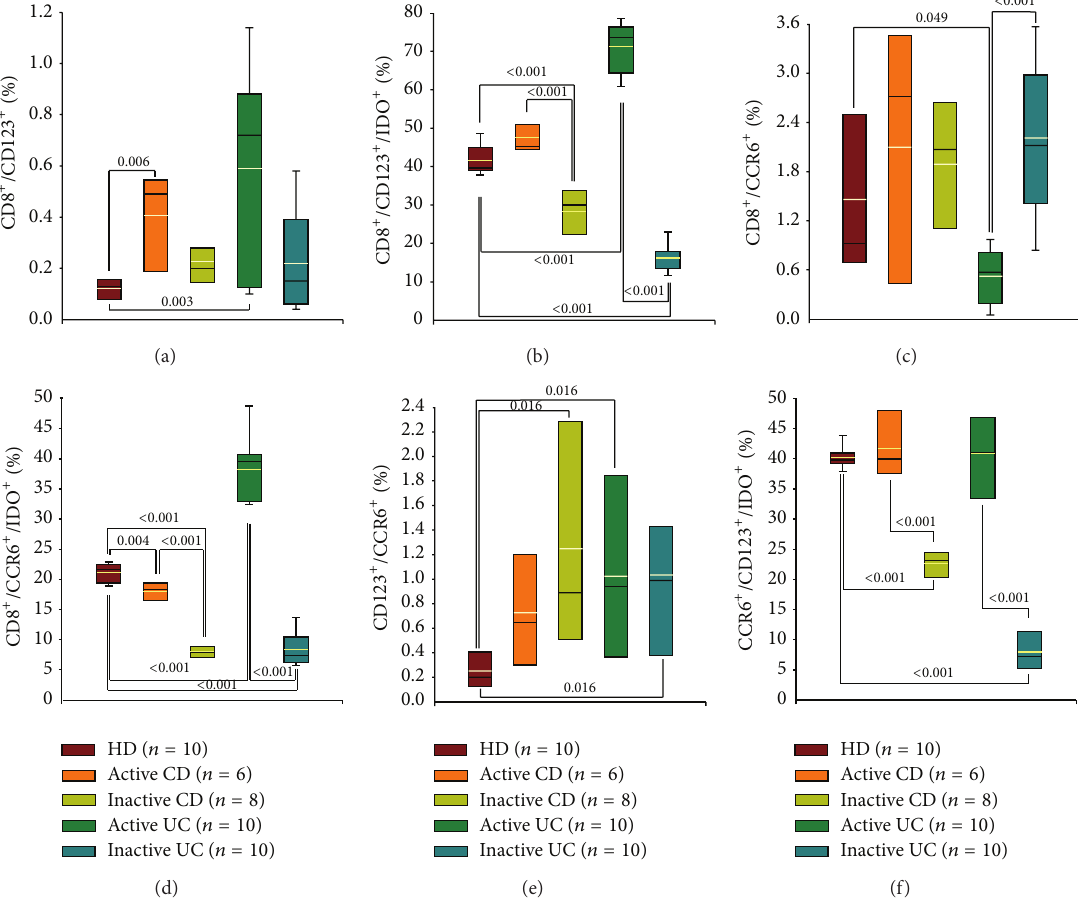
Figure 5: Percentage of IDO-expressing circulating cells in IBD (UC and CD) patients. Bar graphs show percentage of (a) CD123 + /CD8 𝛼 +